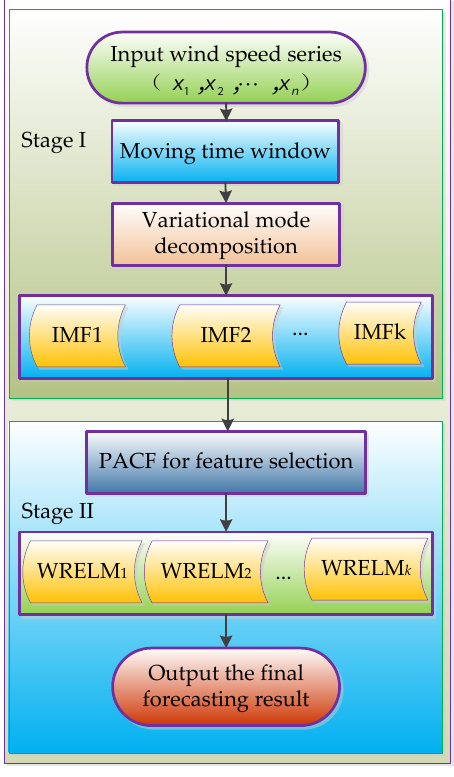
Figure 1. Structure of the new hybrid wind speed forecasting model.